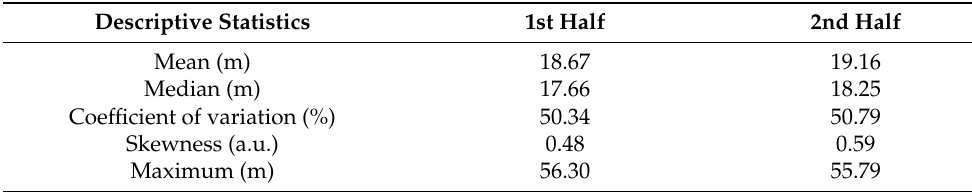
Table 1. Characterization of the distance from the referee to the ball.